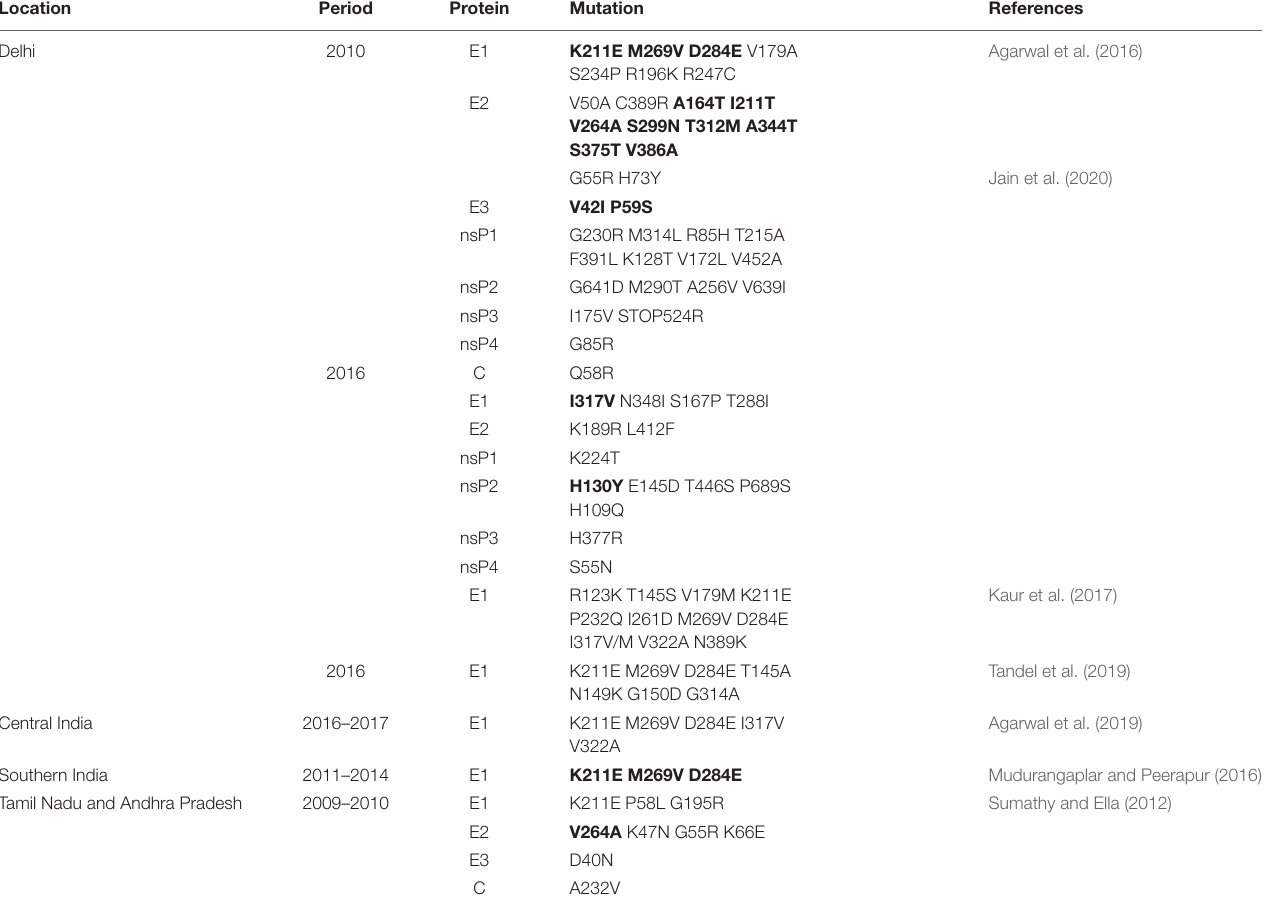
TABLE 2 | Few CHIKV mutations reported between 2010 and 2020. Location